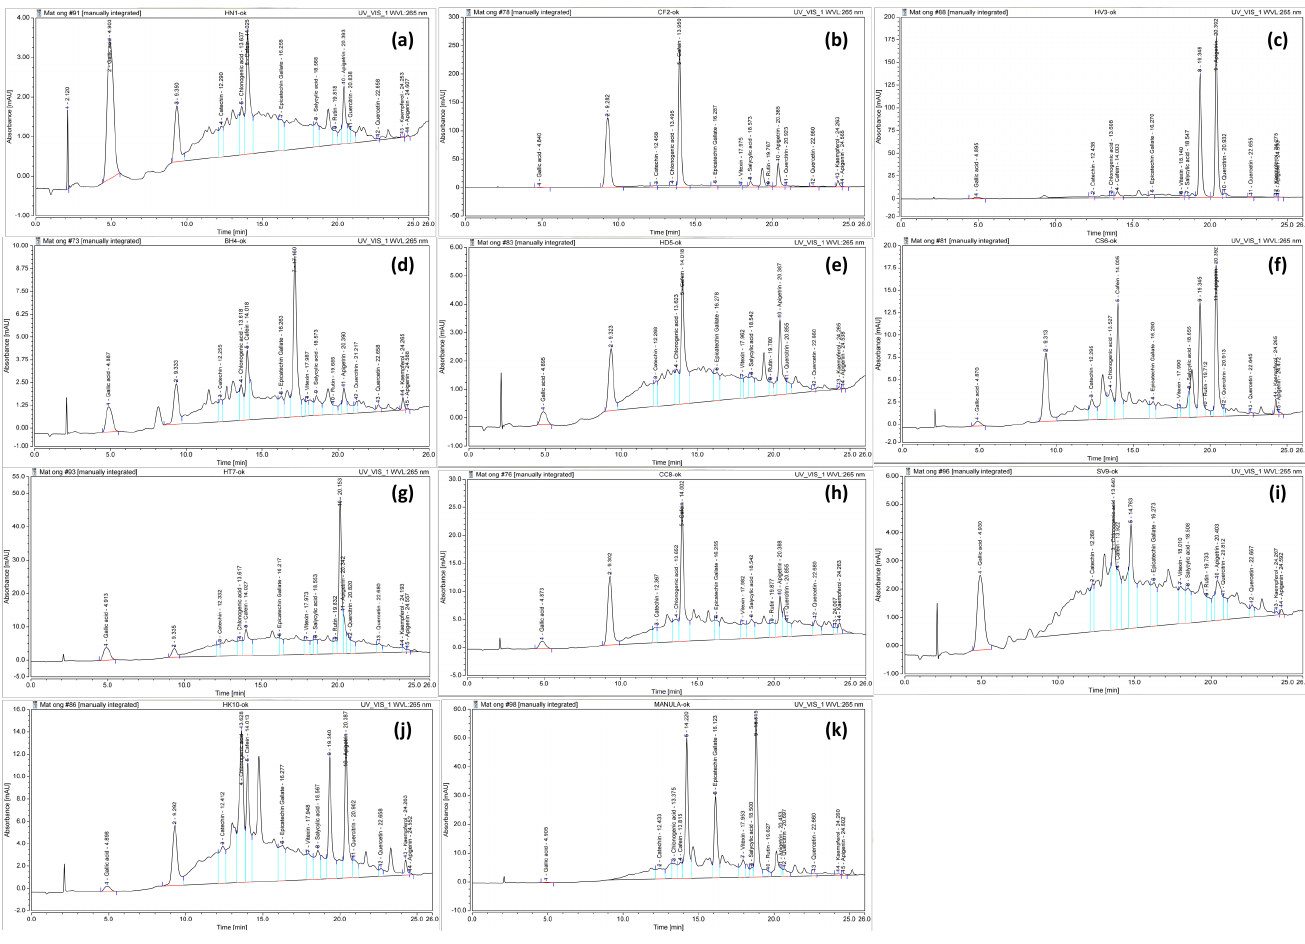
Figure 2. High-performance liquid chromatography chromatogram of ( a ) HN1; ( b ) CF2; ( c ) HV3; ( d ) BH4; ( e ) I HD5; ( f ) CS6; ( g ) HT7; ( h ) CC8; ( i ) SV9; ( j ) HK10 and ( k ) Table 7. Phenolic content of honey samples.